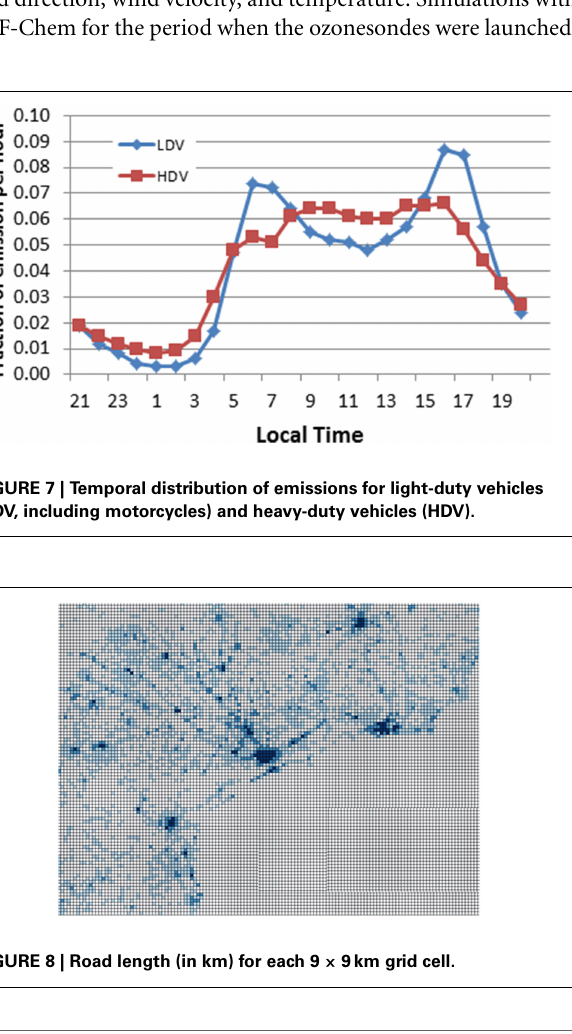
Table 7 | Surface data available for evaluation of the modeling